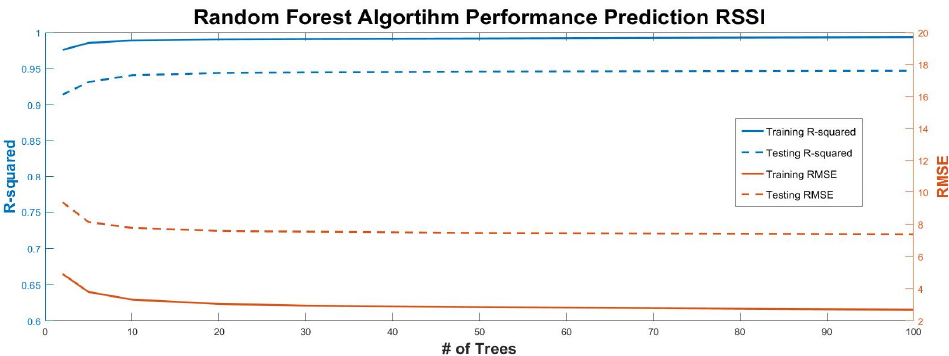
Figure 8. Performance metrics plot for random forest algorithm against different number of trees.